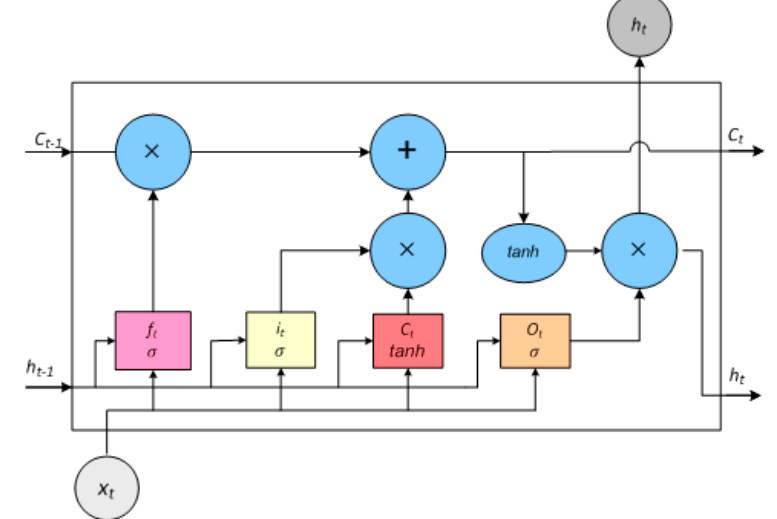
Figure 3. Standard LSTM Structure. The colored rectangles depict the LSTM gates, and the blue circles represent the arithmetic operation.